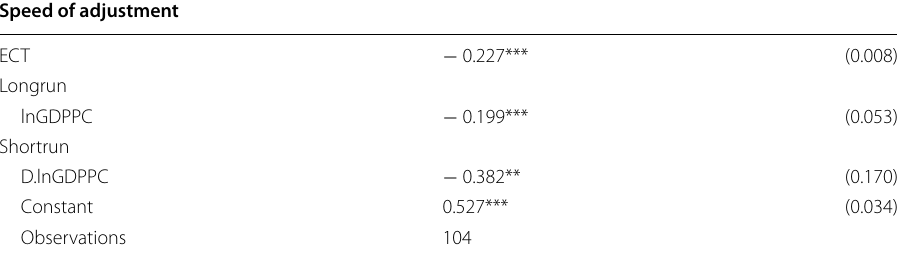
Standard errors in